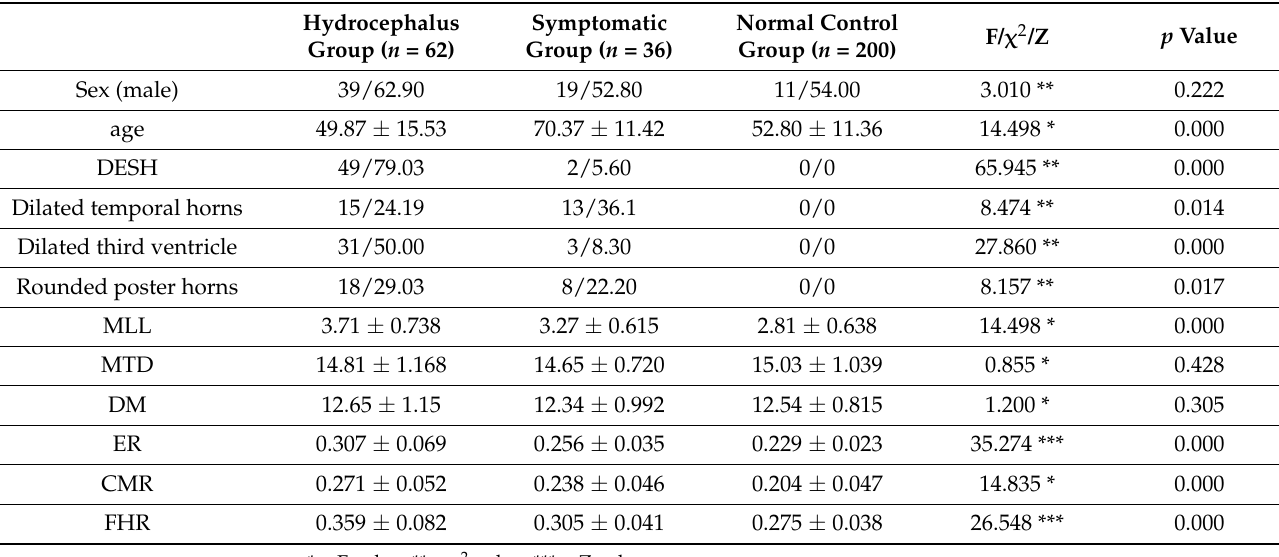
Table 2. The Baseline Statistics Enrolled Patients.